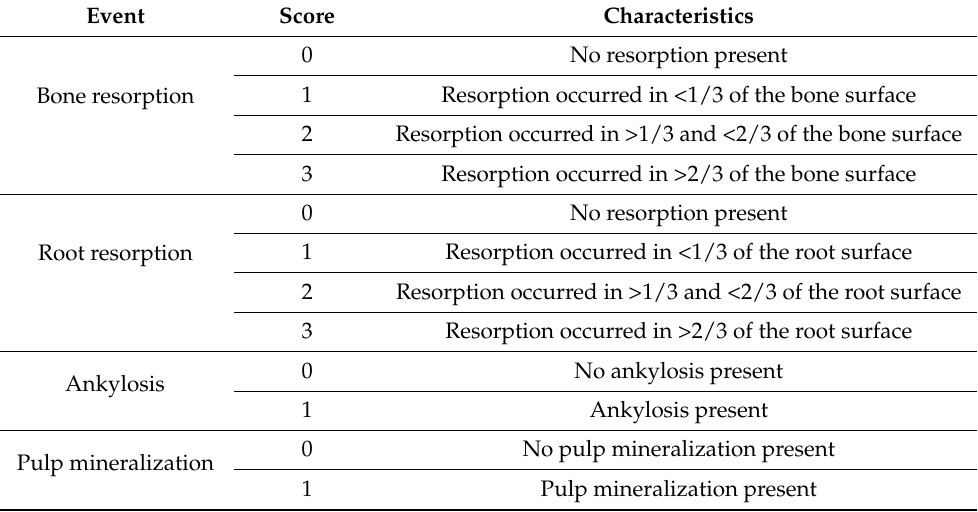
Table 2. Scores for quantitative analysis in micro-microcomputed tomography image.